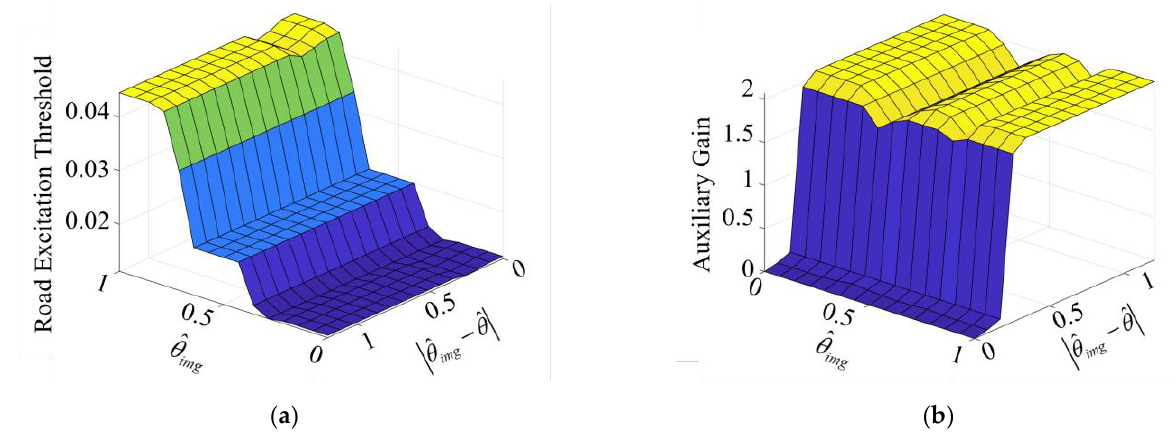
Figure 11. Fuzzy control surfaces. ( a ) Fuzzy control surface of the road excitation threshold to trigger the DIFE; ( b ) Fuzzy control surface of the auxiliary gain. Table 2. Fuzzy rules for the road excitation threshold and the auxiliary gain.